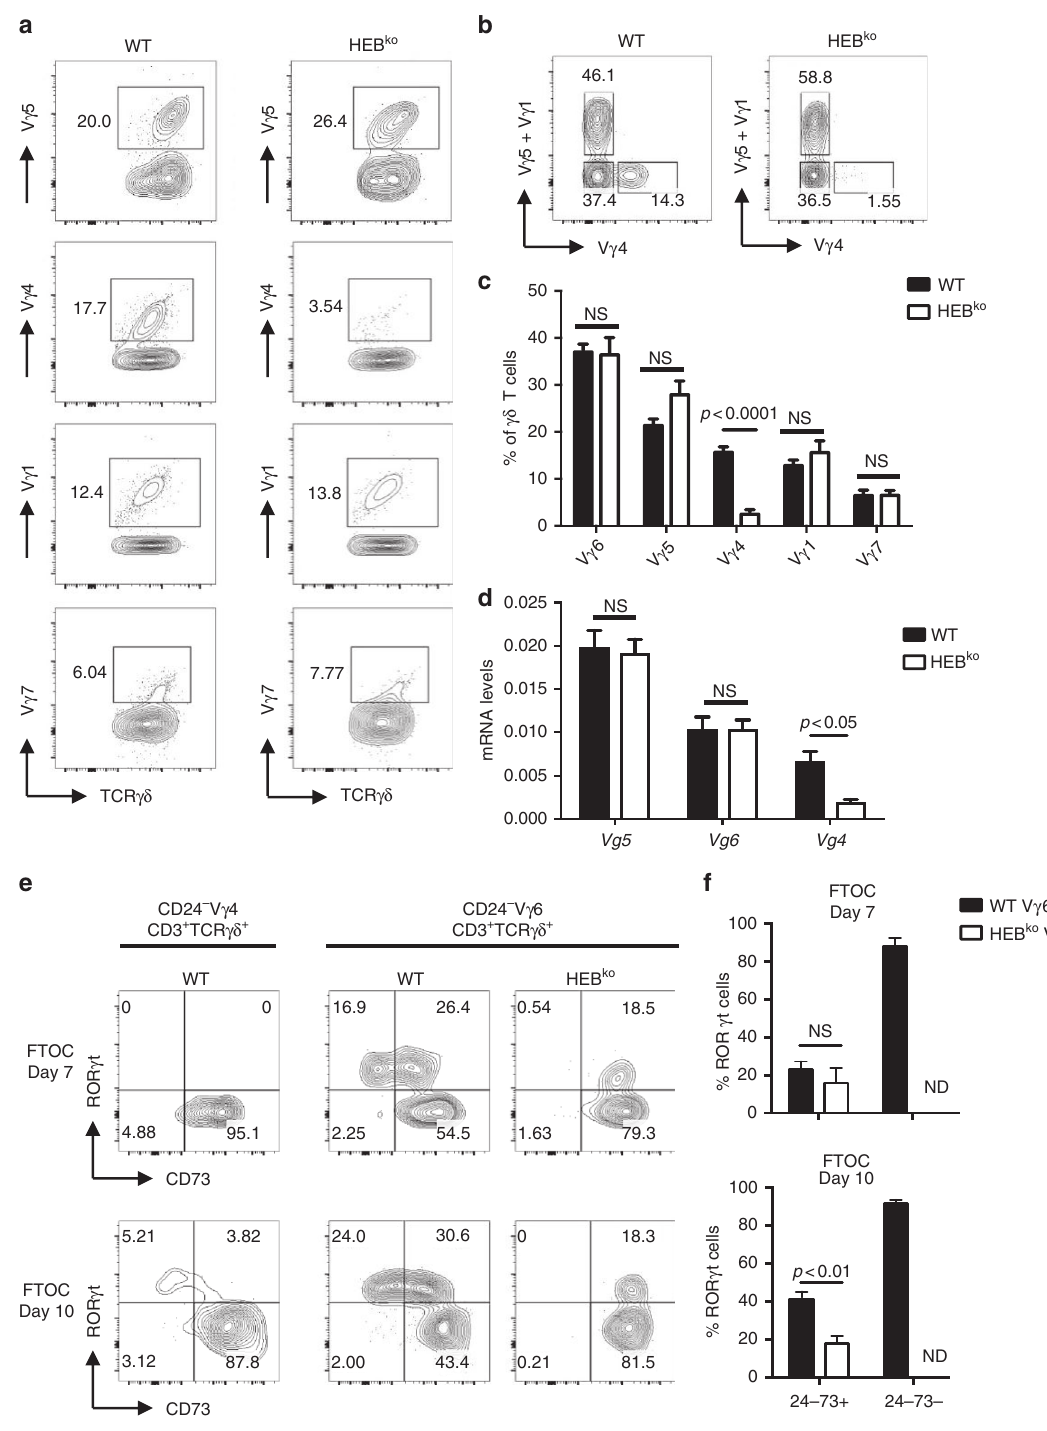
Fig. 7 Multiple defects in V γ 4 and V γ 6 cells in HEB ko FTOCs. a Representative FACS plots showing the frequencies of V γ subsets among all γδ T cells in WT and HEB ko d7 FTOCs. b Gating strategy for V γ 6 (V γ 5/1 − V γ 4 − CD3 + TCR γδ + ). c Quanti fi cation of frequencies of V γ subsets among total γδ T cells in WT and HEB ko d7 FTOCs. d mRNA levels of V γ transcripts in γδ T cells sorted from WT and HEB ko d7 FTOCs, as determined by qRT-PCR. Levels are relative to β -actin. e Intracellular expression of ROR γ t vs. surface CD73 in mature V γ 4 (CD3 + TCR γδ + V γ 4 + CD24 − ) from WT FTOCs, and mature V γ 6 (CD3 + TCR γδ + V γ 5/4/1 − CD24 − ) cells from WT and HEB ko FTOCs. f Quanti fi cation of the frequencies of ROR γ t + cells among CD24 − CD73 + V γ 6 cells and CD24 − CD73 − V γ 6 cells from WT and HEB ko FTOCs. All plots are gated on the CD3 + TCR γδ + population. Numbers in FACS plots indicate frequency within each gate. Data are representative of at least three independent experiments with at least 3 mice per group. Center values indicate mean, error bars denote s.e. m. p -values were determined by two tailed Student's t- test. ND = not done (due to low cell number). NS = not signi fi